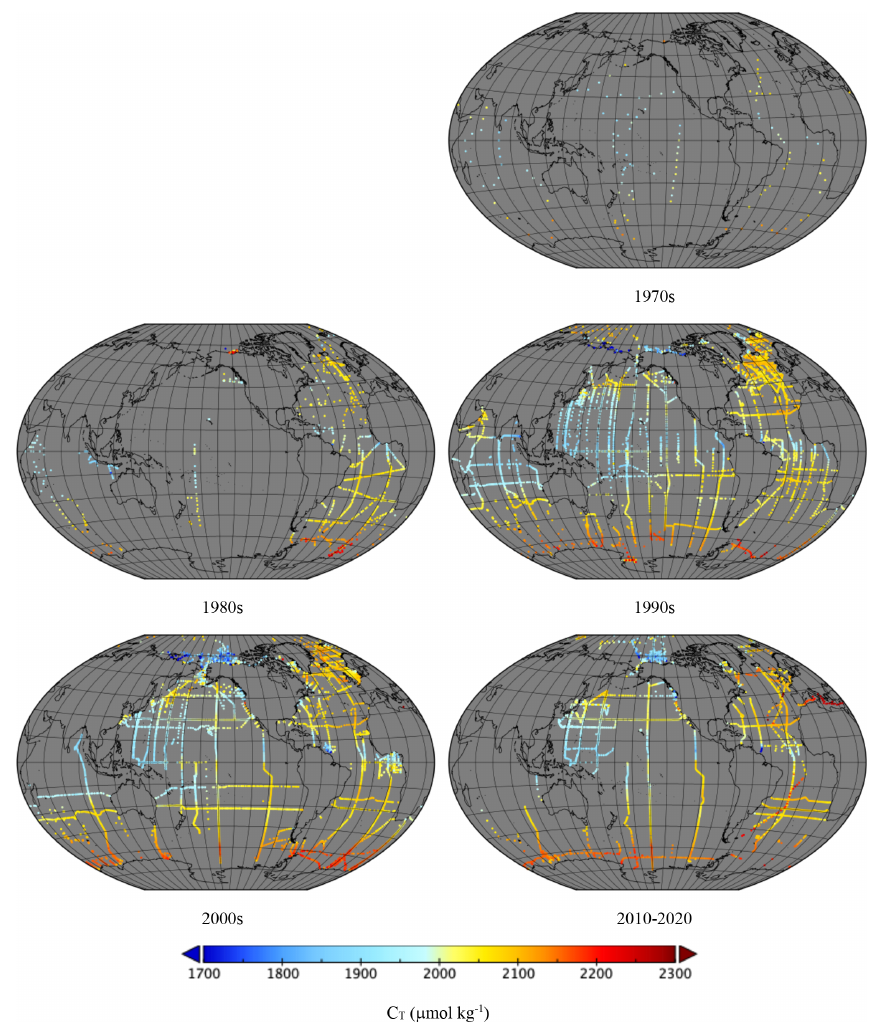
Figure 13. Mean C T (µmolkg − 1 ) divided into decades: 123 ROIs in the 1970s, 971 in the 1980s, 4613 in the 1990s, 5672 in the 2000s and 3662 from 2010 to